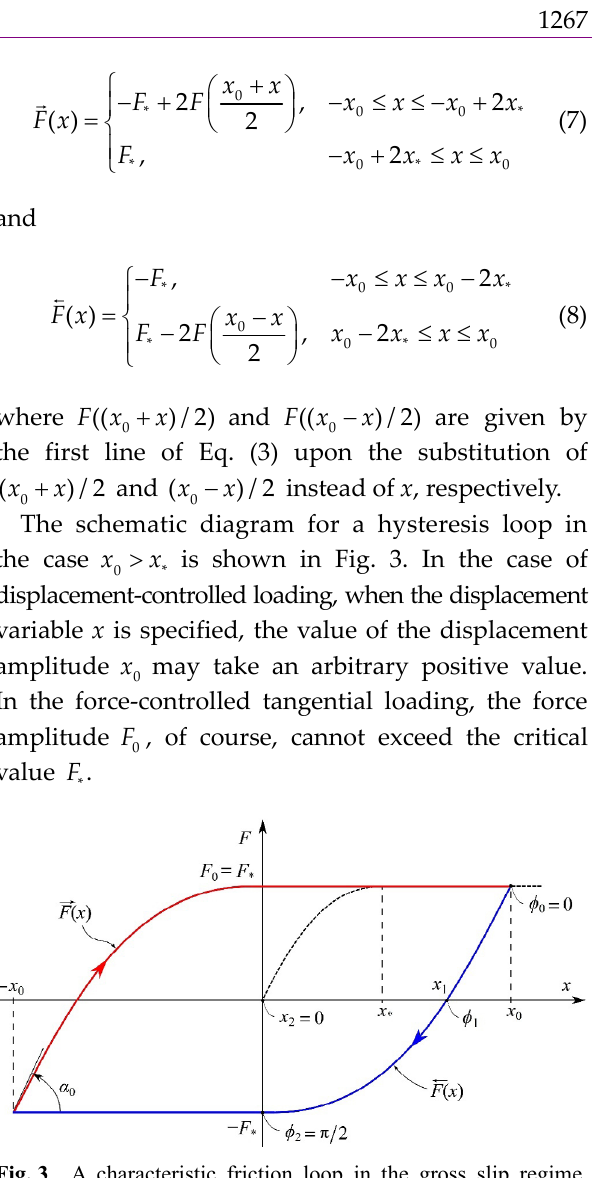
Fig. 3 A characteristic friction loop in the gross slip regime, when  x x 0 *